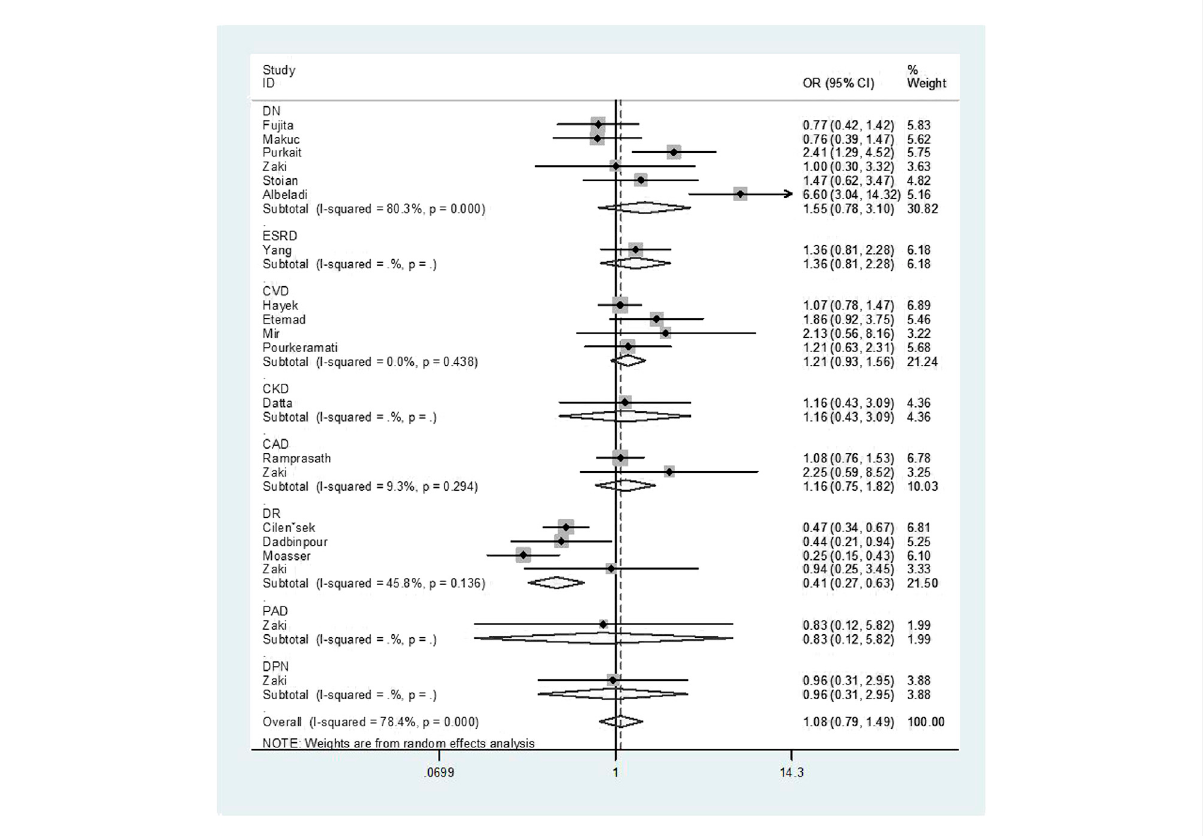
FIGURE 2 Forest plot of the association between GSTT1 polymorphism and T2DM complications